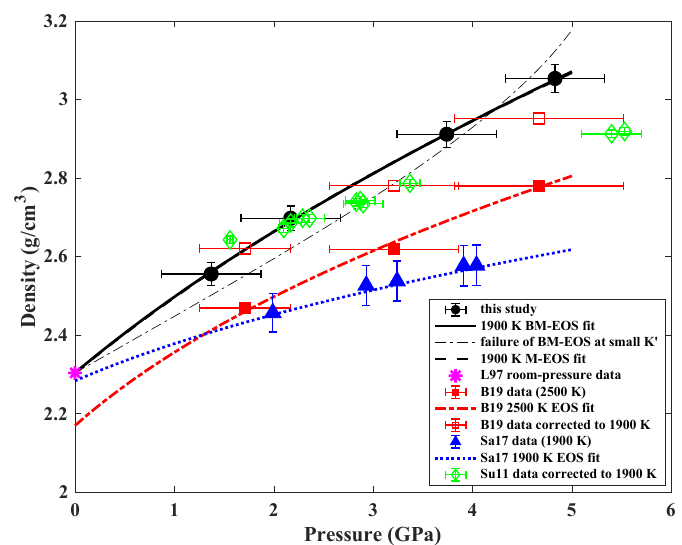
Figure 4. Density of jadeite melt as a function of pressure measured in this study and its comparison with previous studies. The shaded area is the uncertainty of the compression curve based on the Birch-Murnaghan equation of state (BM-EOS) fitting results. The solid black line for BM-EOS overlaps with the dashed black line for Murnaghan equation of state (M-EOS). L97-Lange [54], B19-Bajgain et al.